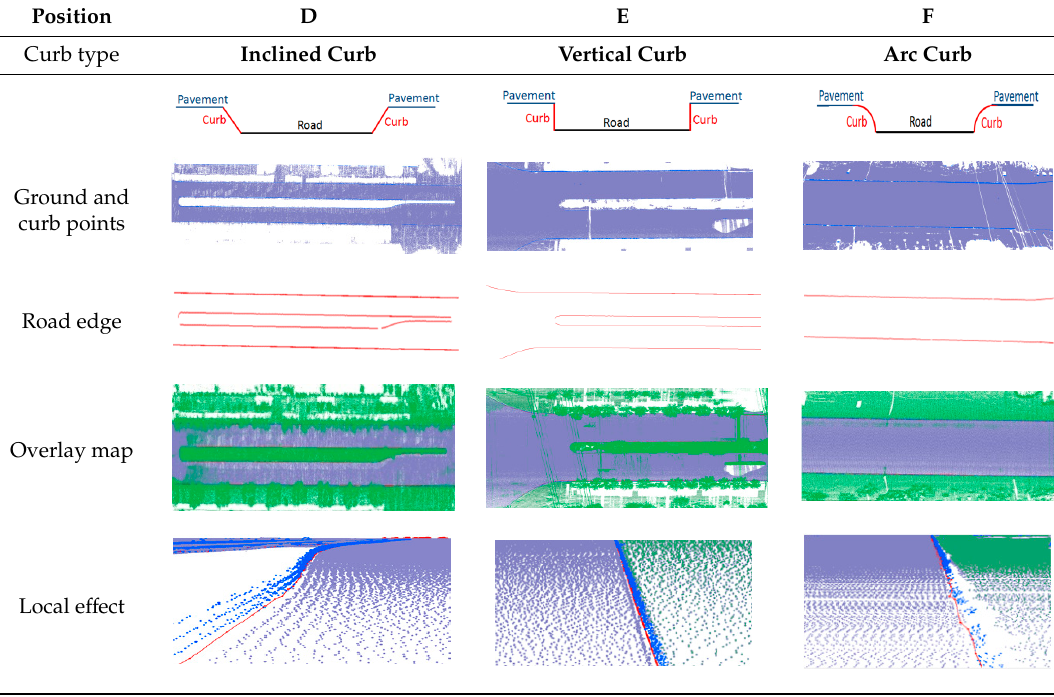
Table 4. Extraction results for three different types of road